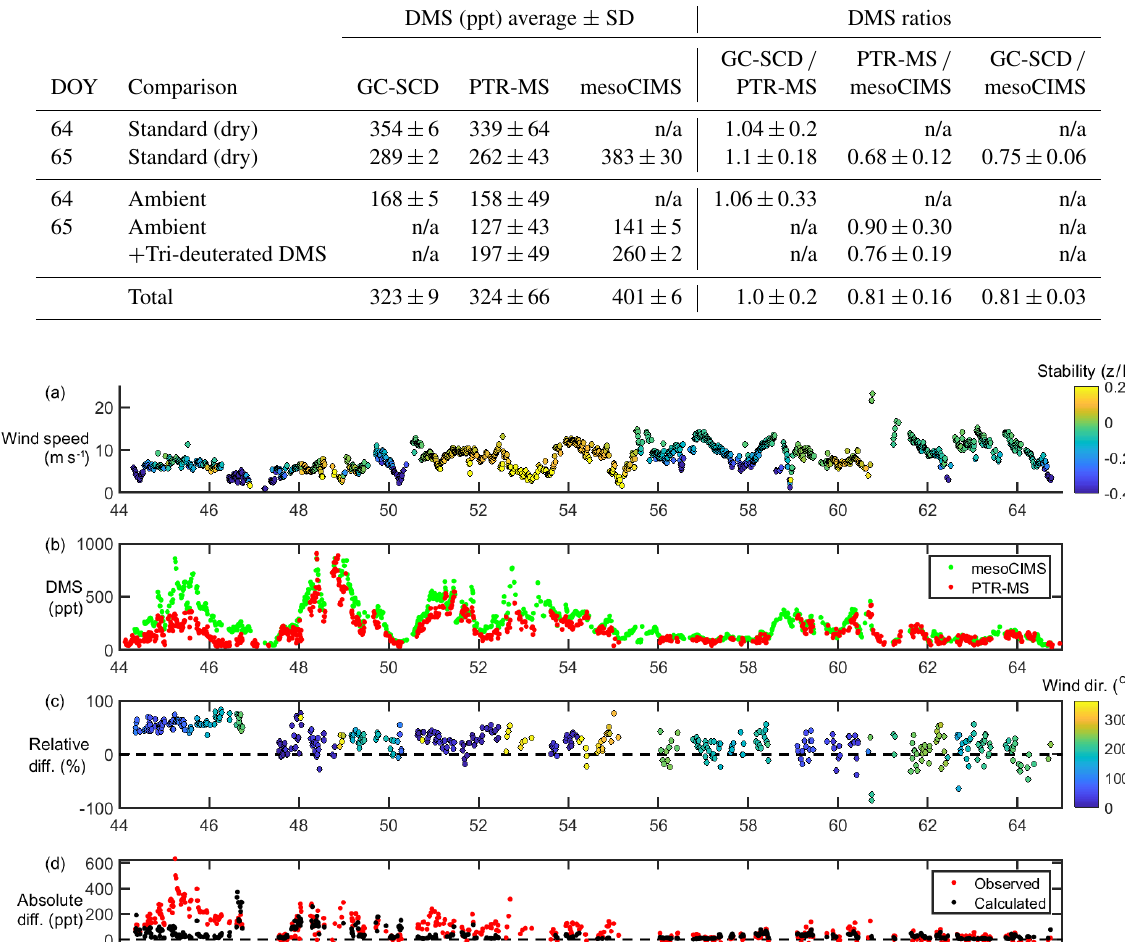
Table 1. Results of the DMS bag sample intercomparison study undertaken during the SOAP voyage. Note that a 1s PTR-MS dwell time for m/z 63 and m/z 66 was used during the intercomparison compared to the 10s during ambient measurements; as such, the PTR-MS standard deviation reported here is expected to be ∼ 3 times higher than during ambient measurements. “Total” refers to the ambient DMS + spiked tri-deuterated DMS bag sample on DOY 65.